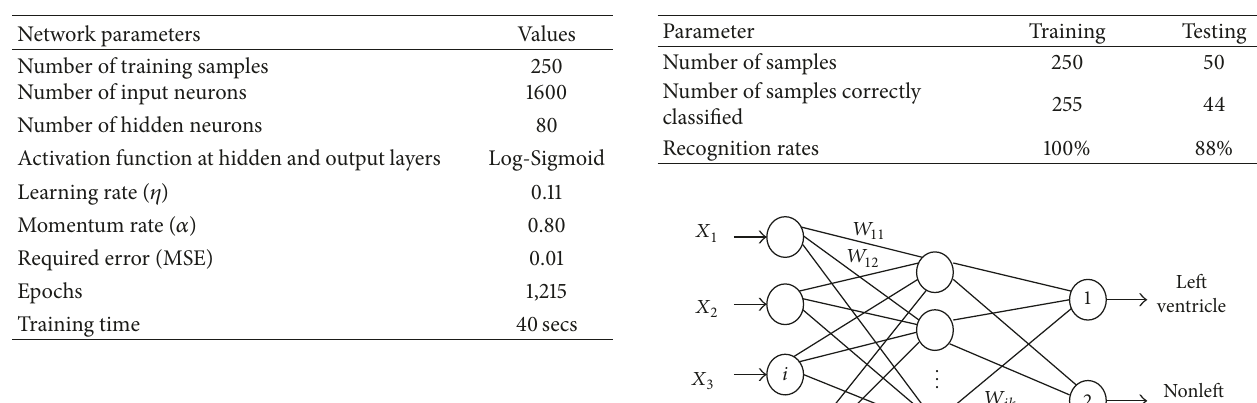
Table 1: Final training parameters for BPNN. Table 2: Recognition rates for BPNN.